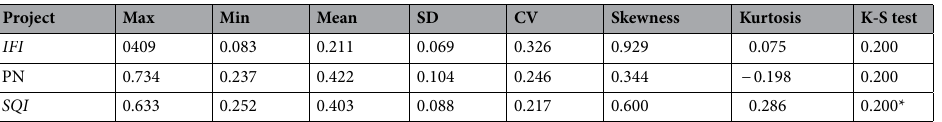
Table 5. Comprehensive descriptive statistics of soil quality in the study area. *After logarithmic conversion. Max maximum, Min minimum, SD standard deviation, CV coefficient of variation, K-S Kolmogorov–Smirnov, IFI integrated fertility index, PN Nemerow pollution index, SQI soil quality index.